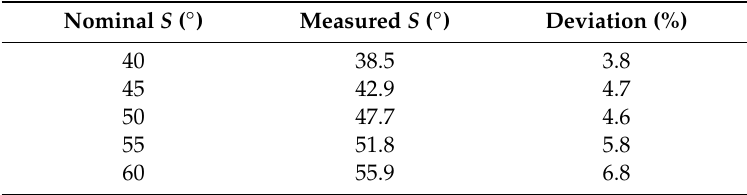
Table 1. Nominal wall slope S given by CAD in comparison to measured values.